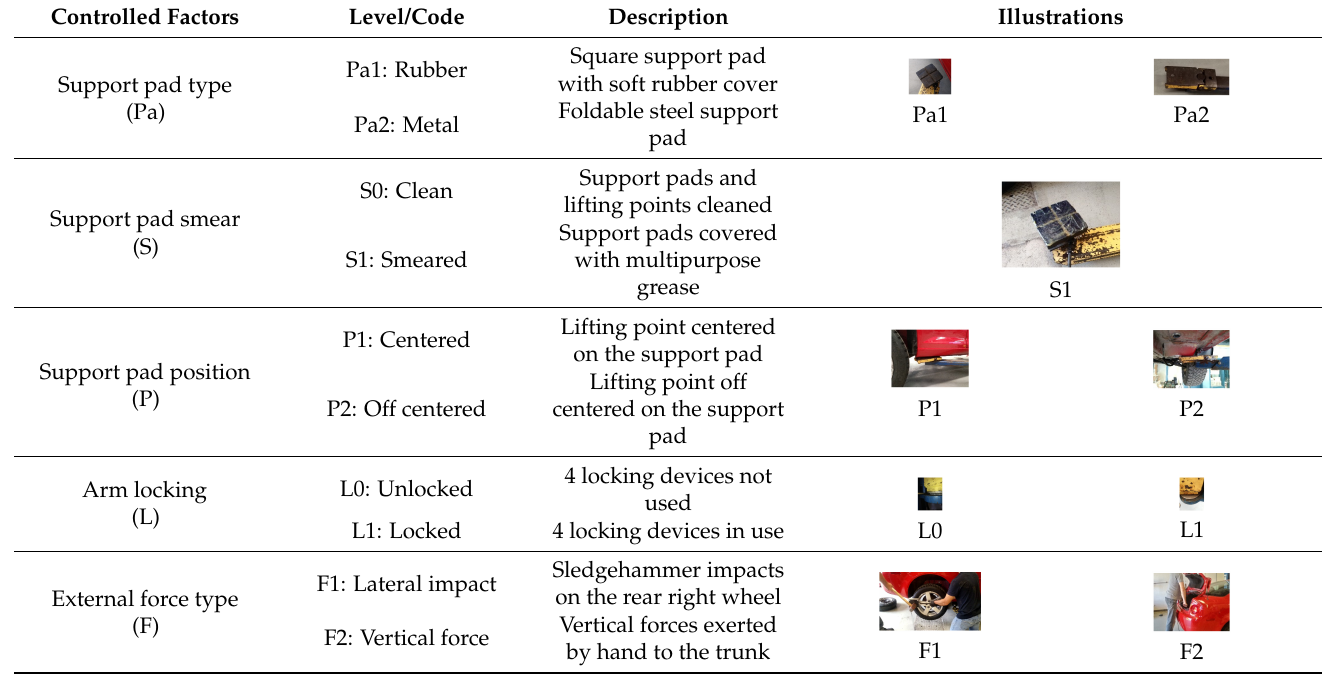
Table 2. Controlled factors in the experimental